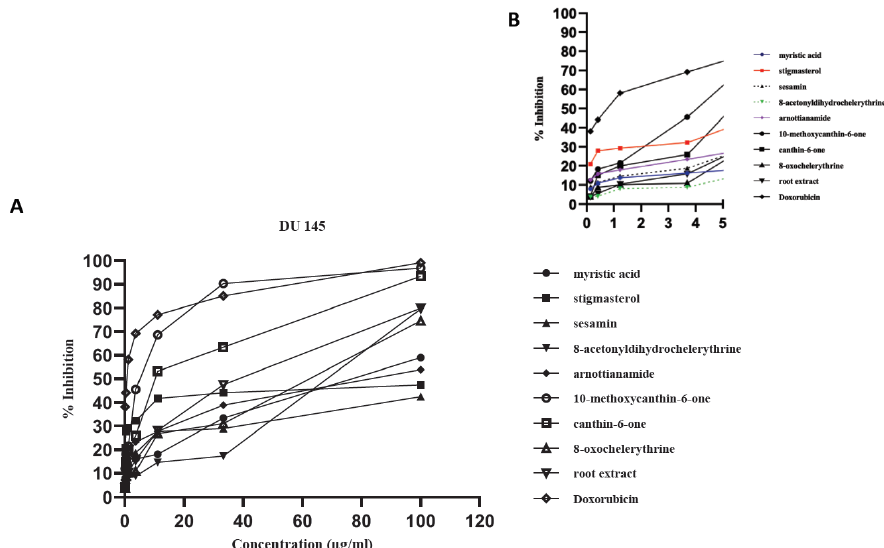
Figure 3. Antiproliferative activity of the tested samples against the human prostate cancer cell line (DU 145). Antiproliferative activity of the tested samples against various cancer cell lines recoded as % growth inhibition. (A) Biphasic growth curve of dose-dependent anti-proliferation effects: 0–100 µg/mL. (B) Effect of test samples at low concentrations: 0–5 µg/mL.